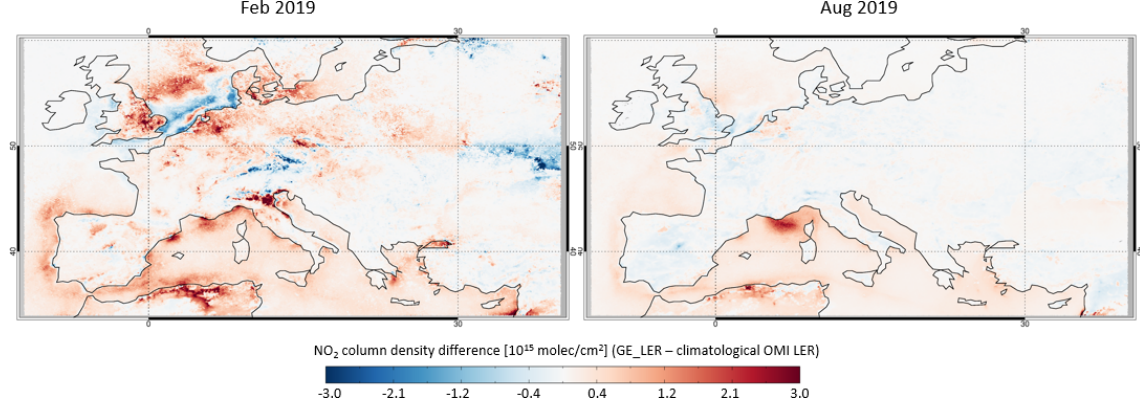
Figure 8. Differences in the tropospheric NO 2 columns retrieved using the climatological OMI LER and GE_LER over Europe in February and August 2019. Only measurements with a cloud radiance fraction less than 0.5 are